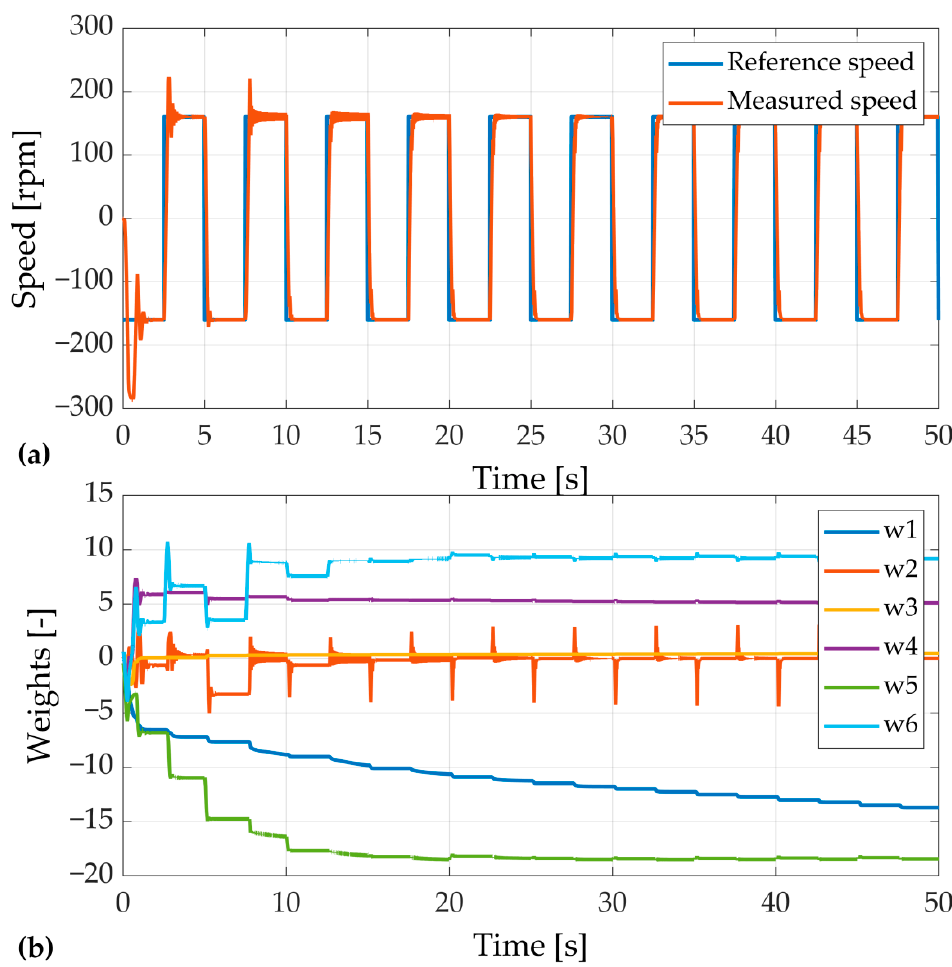
Figure 10. Adaptation process of the speed controller: ( a ) transients of speed; and ( b ) weights values.